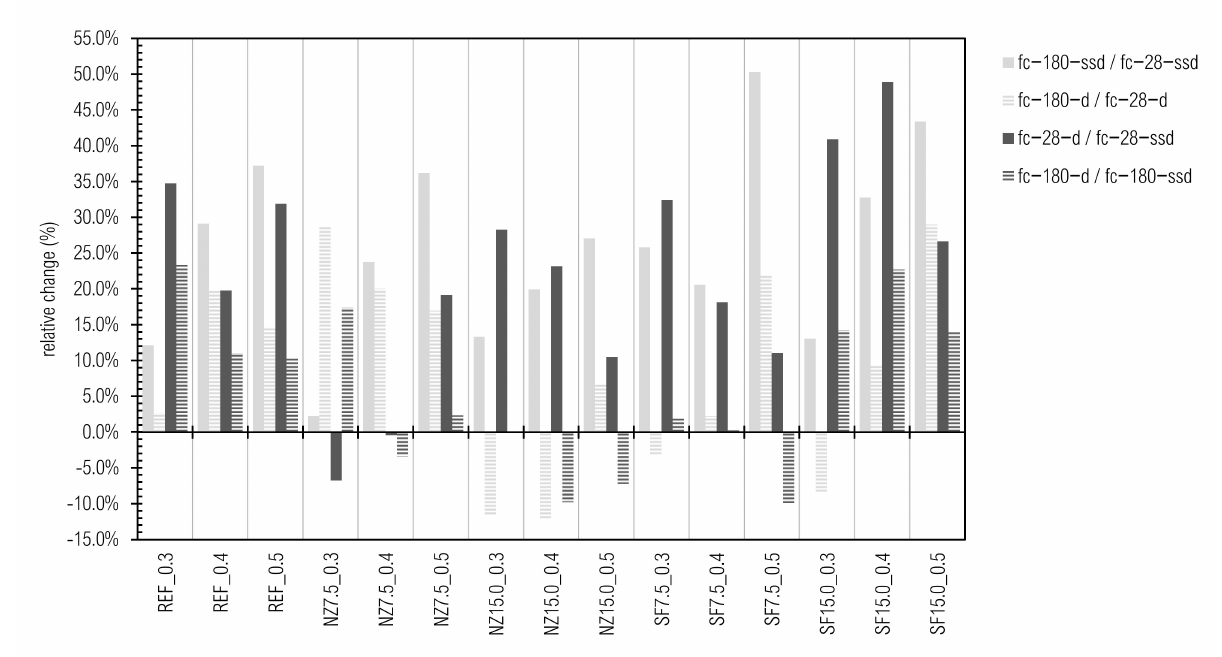
Figure 10. Development of compressive strength and mutual